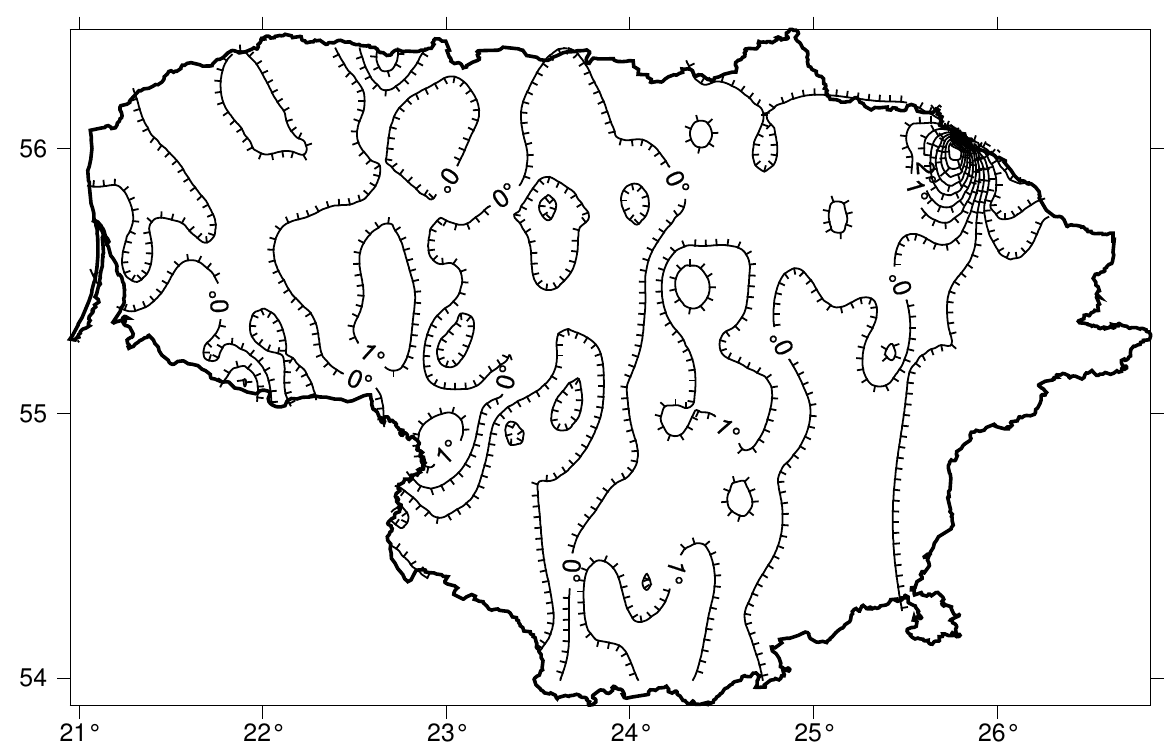
Fig 3. Map of differences between updated map by K. Sleževi č ius for epoch 2000.5 and the